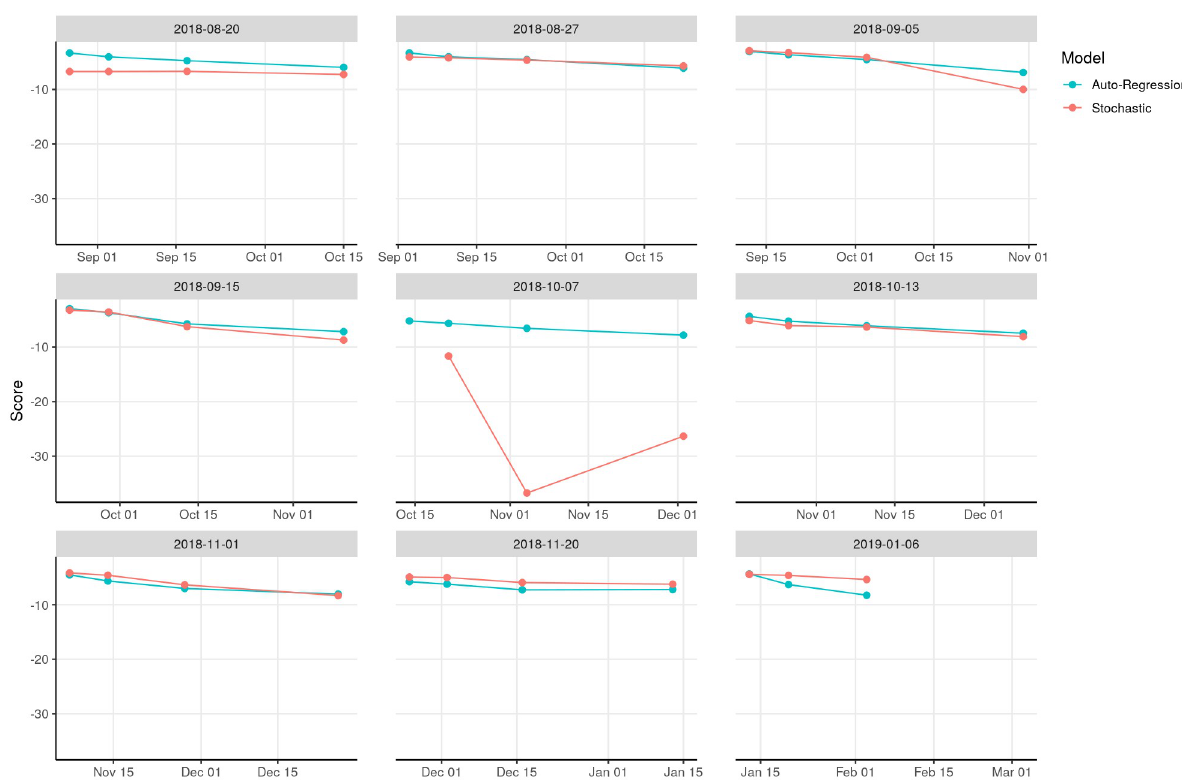
Fig 3. Log-likelihood scores of stochastic and auto-regression projections in prospective